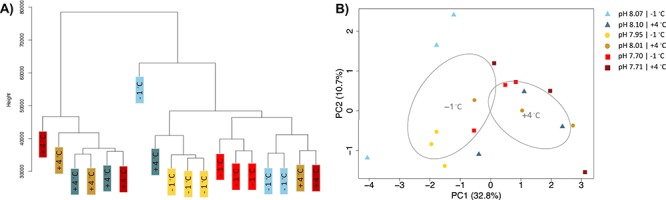
A) Hierarchical clustering of gene expression for individuals cultured at +4 °C and − 1 °C. B) Biplot of the first two principle components, sample day is represented by icon shape while pH is designated by color.